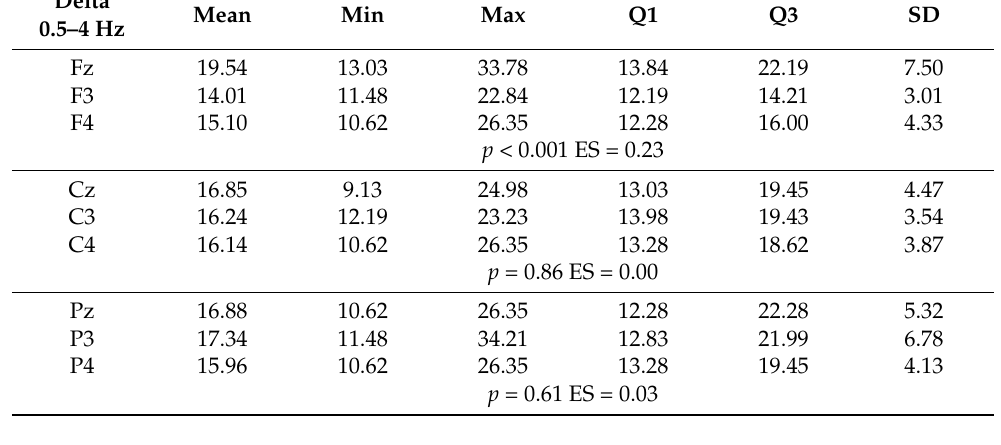
Table 2. Descriptive statistics of Delta waves from all channels ( µ V).